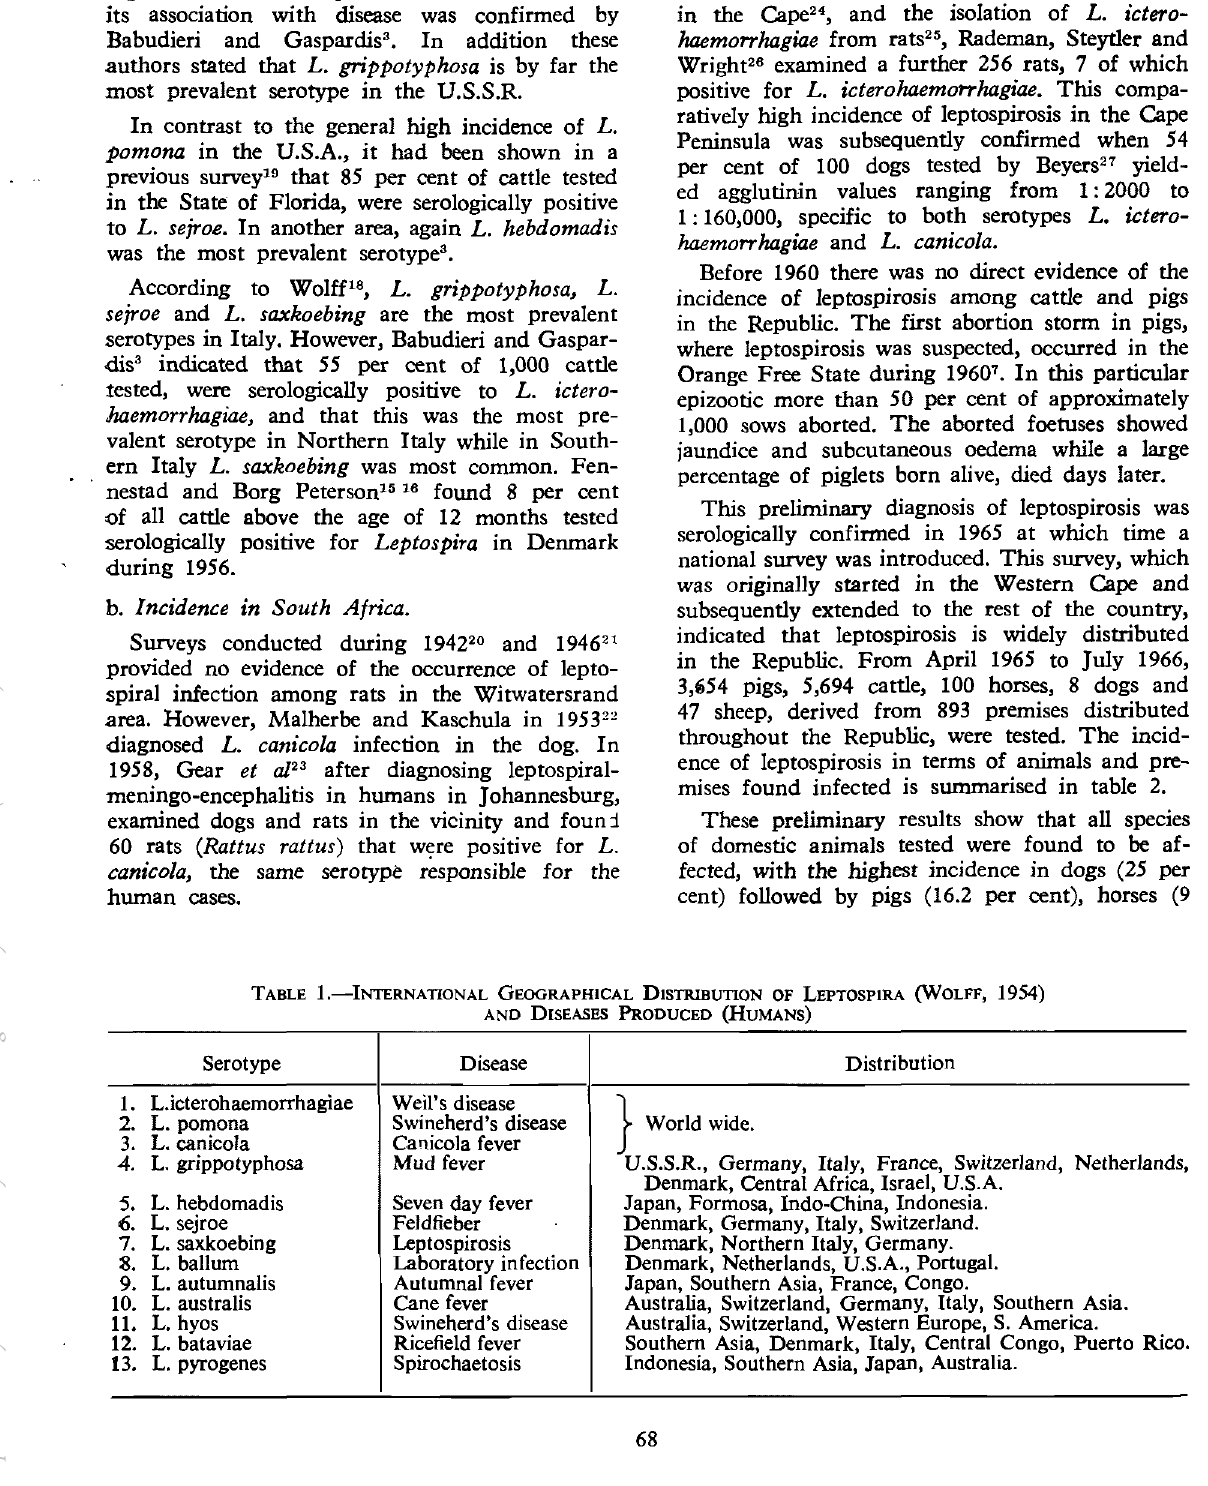
TABLE l.-INTERNATIO~AL GEOGRAPHICAL DISTRIBUTION OF LEPTOSPIRA (WOLFF, 1954) A~D DISEASES PRODUCED (HUMANS)